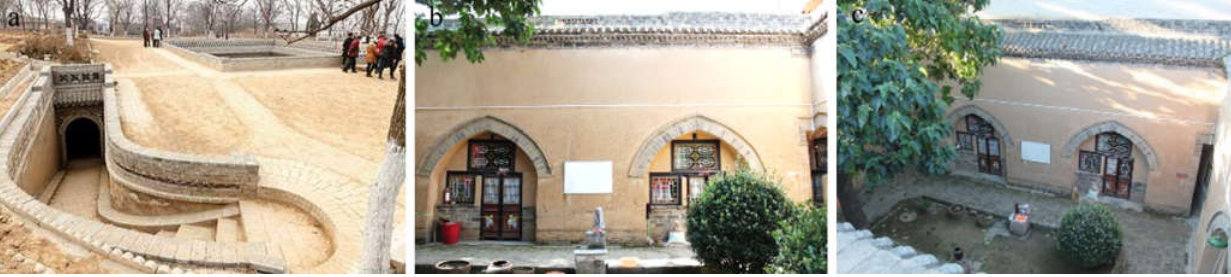
Figure 5. Appearance of underground cave dwellings: ( a ) ramp; ( b ) facade; ( c ) courtyard.